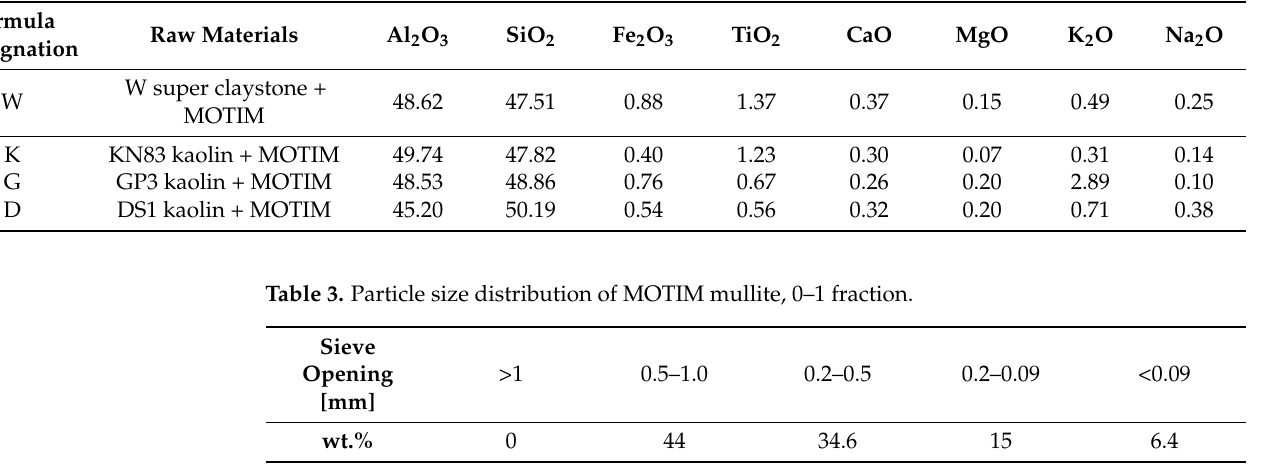
Table 2. Calculated chemical compositions of raw mixes (85% clay, 15% MOTIM mullite) based on WDXRF analysis in wt.%, rounded to two decimal places.